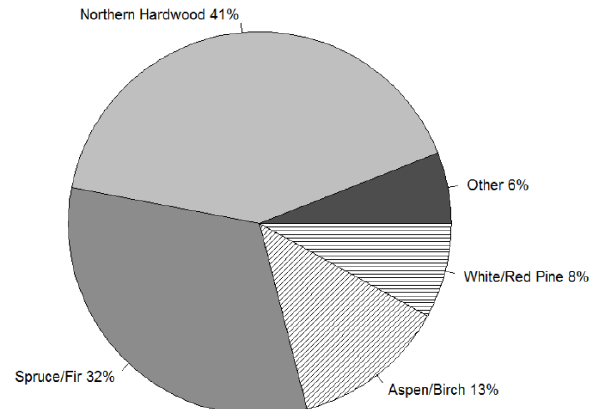
Figure 1. Common forest types in Maine (re-drawn from North East State Foresters Association